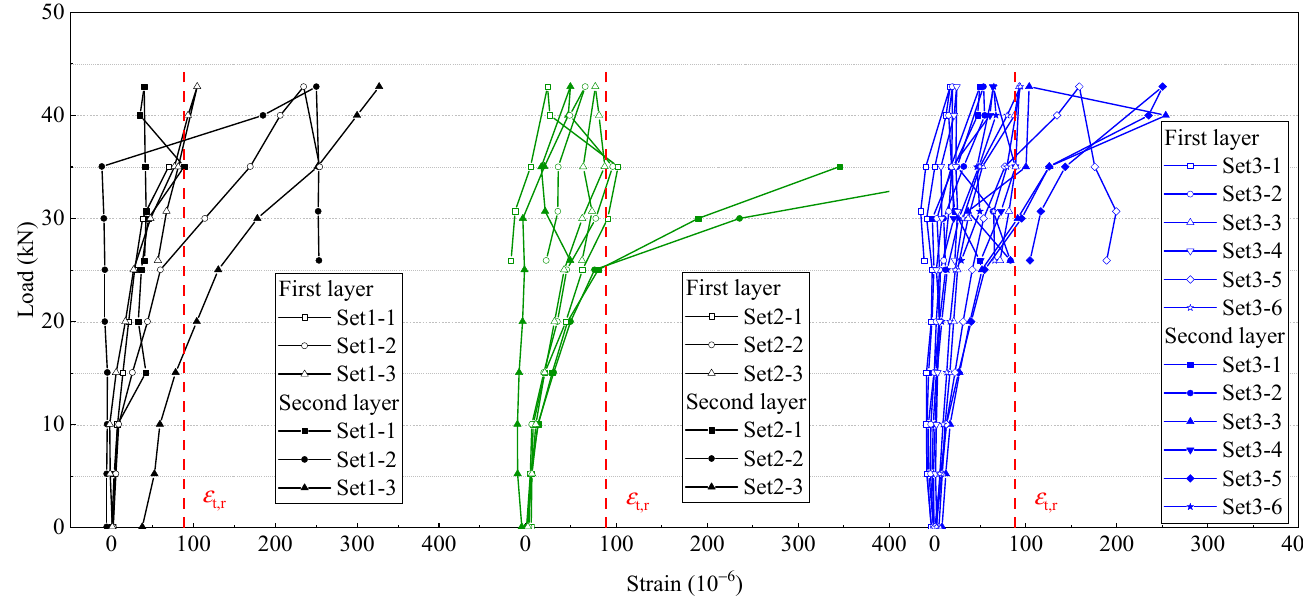
Figure 10. Strains on the surfaces of the rods changed with the load in the stacking test.